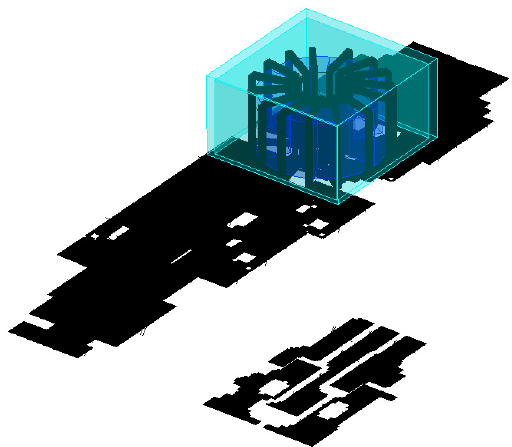
Figure 6. Common mode inductance